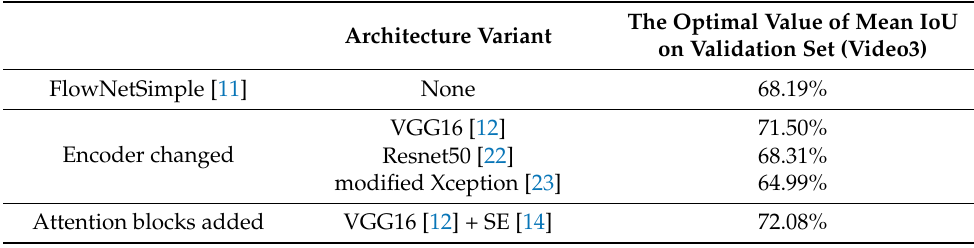
Table 5. Differing performance of rough detection using different encoder or adding attention blocks.